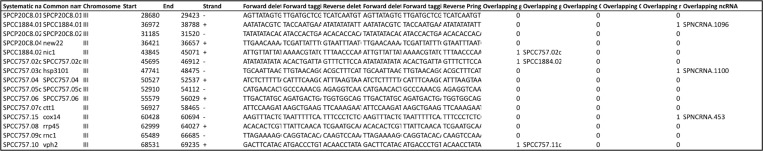
An example of a PRIMED database (fission yeast CDS).In all databases, we provide the systematic and common names, chromosome number, start/end coordinates, transcription strand and forward and reverse primer sequences for each feature under consideration. For deletion databases, also the name(s) and total number of overlapping ORFs, which are disrupted by creating the gene deletion, are indicated.